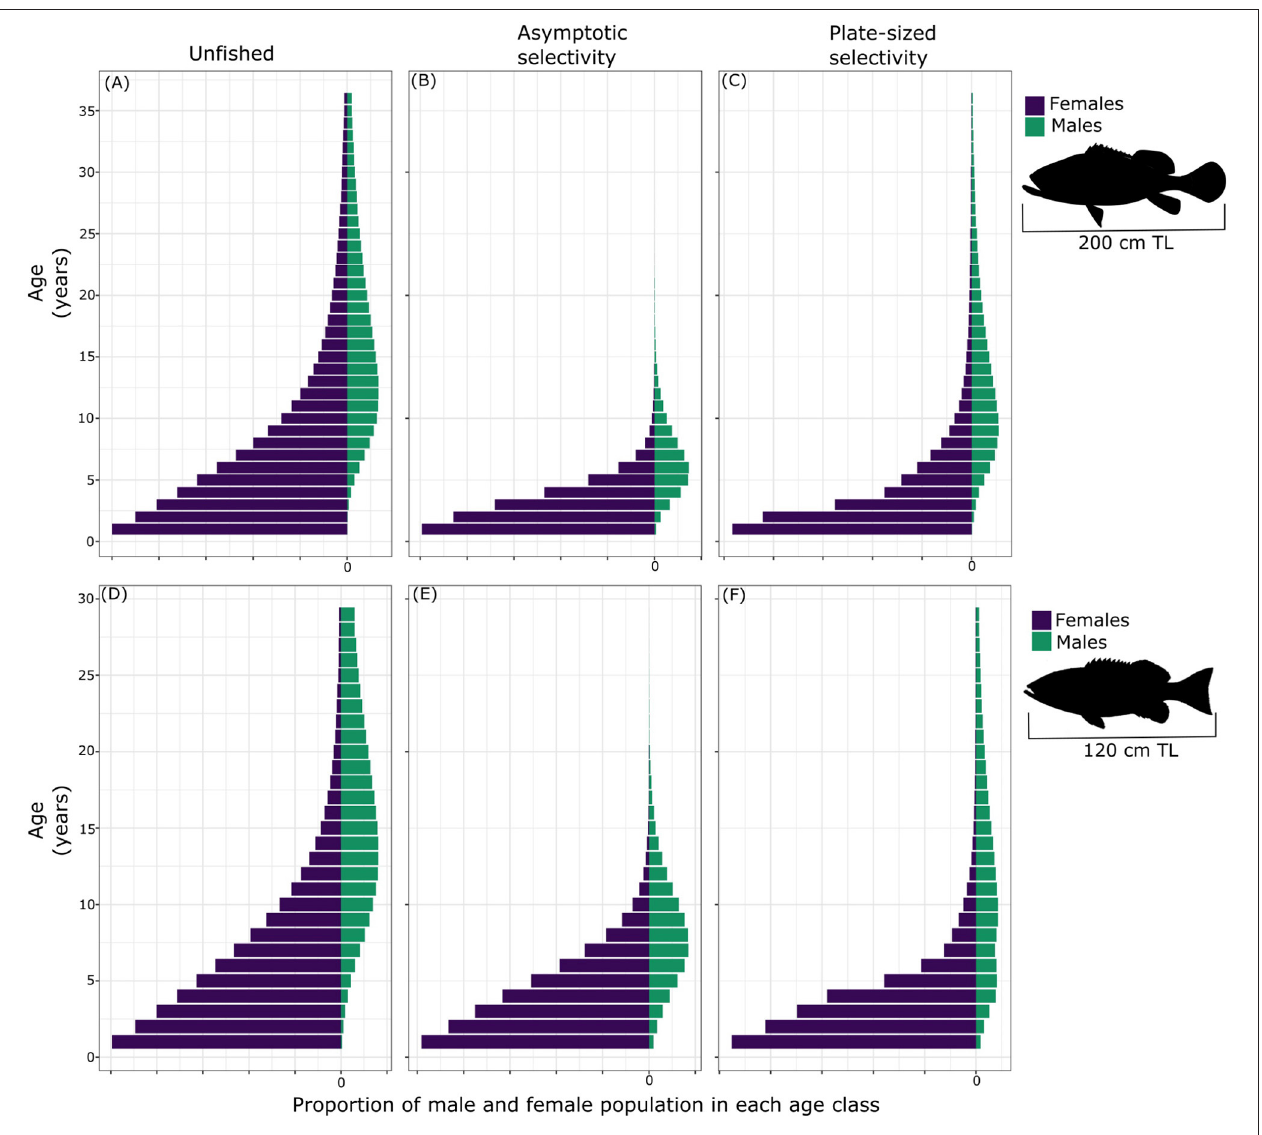
FIGURE 3 | Stable age distribution of unfished (A) , with asymptotic selectivity (B) and with plate-sized selectivity (C) for Pacific goliath grouper and of unfished (D) , with asymptotic selectivity (E) and with plate-sized selectivity (F) of bacalao, with fishing mortality, F = 0.3 and fertilization success, f = 100 %